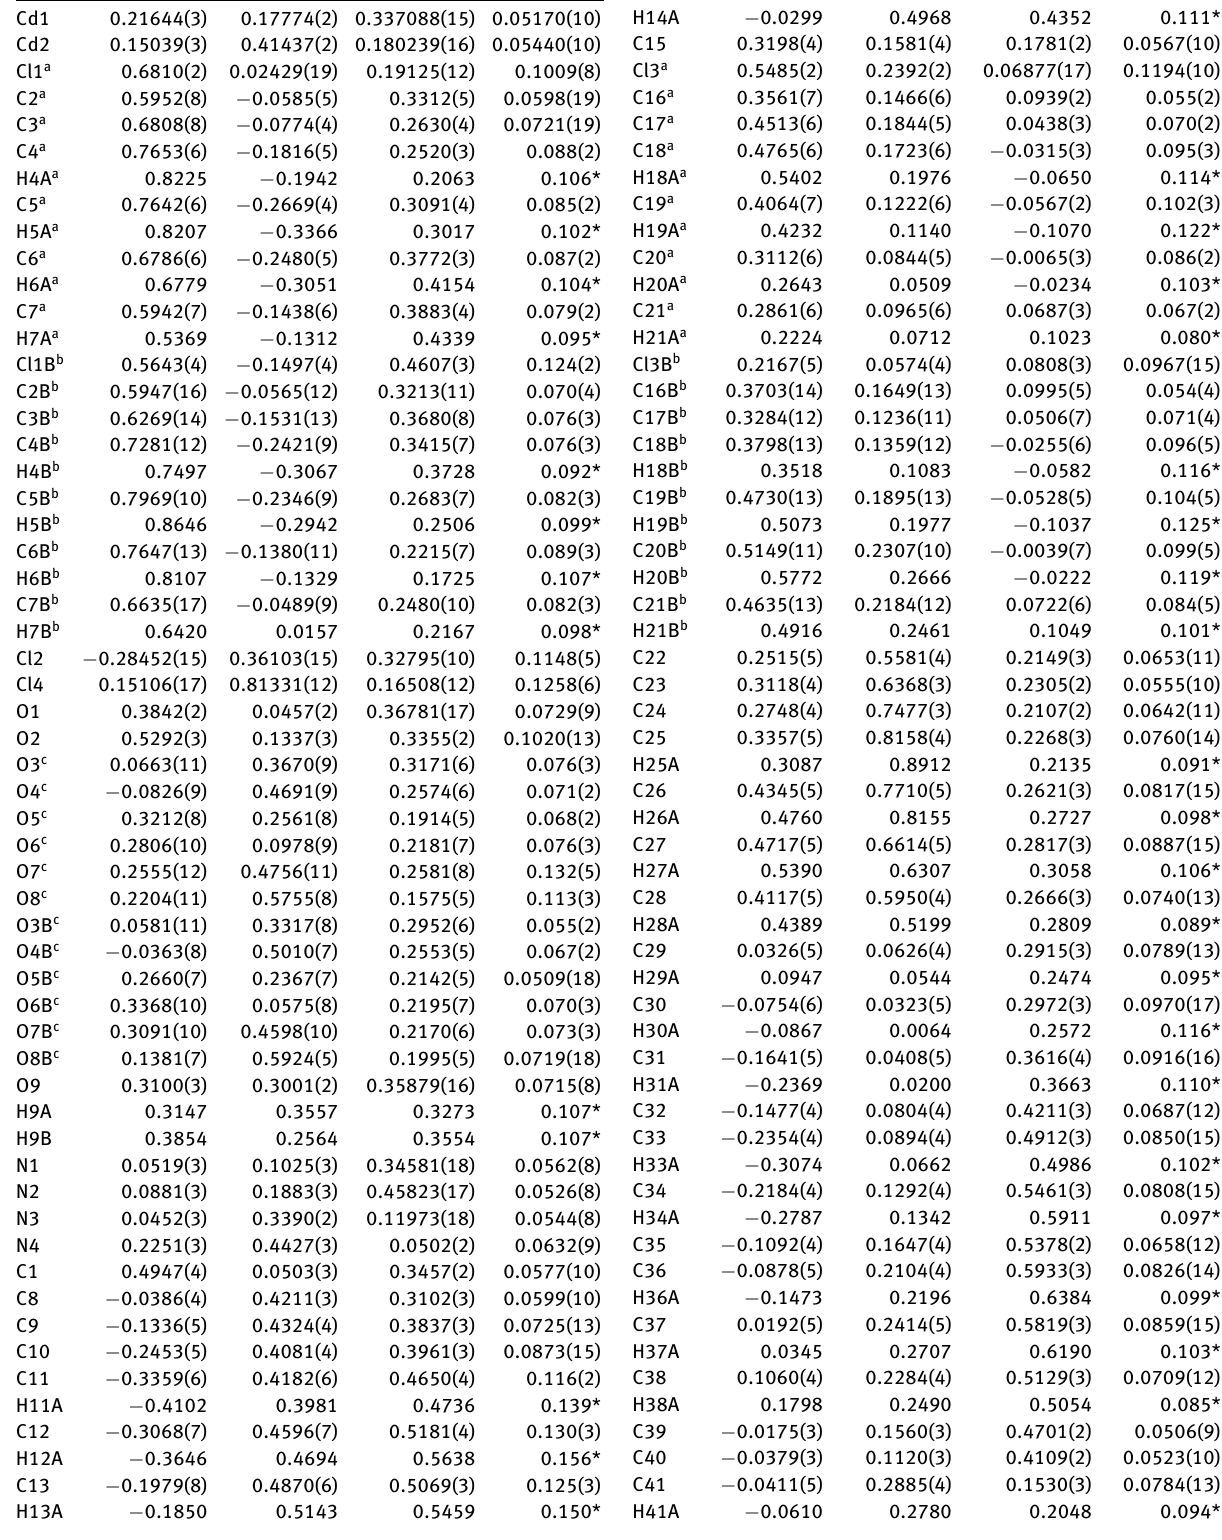
Table 2: Fractional atomic coordinates and isotropic or equivalent isotropic displacement parameters (Å 2